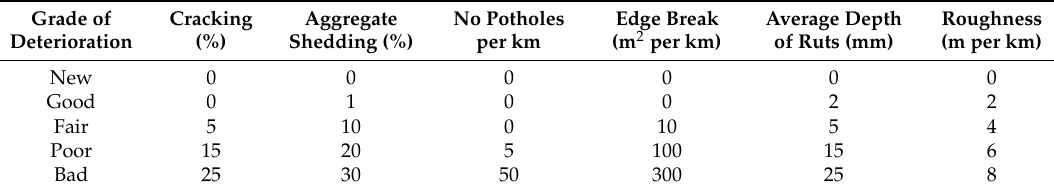
Table 1. Criteria for pavement conditions classification according to the degree of deterioration. Reproduced from [65].